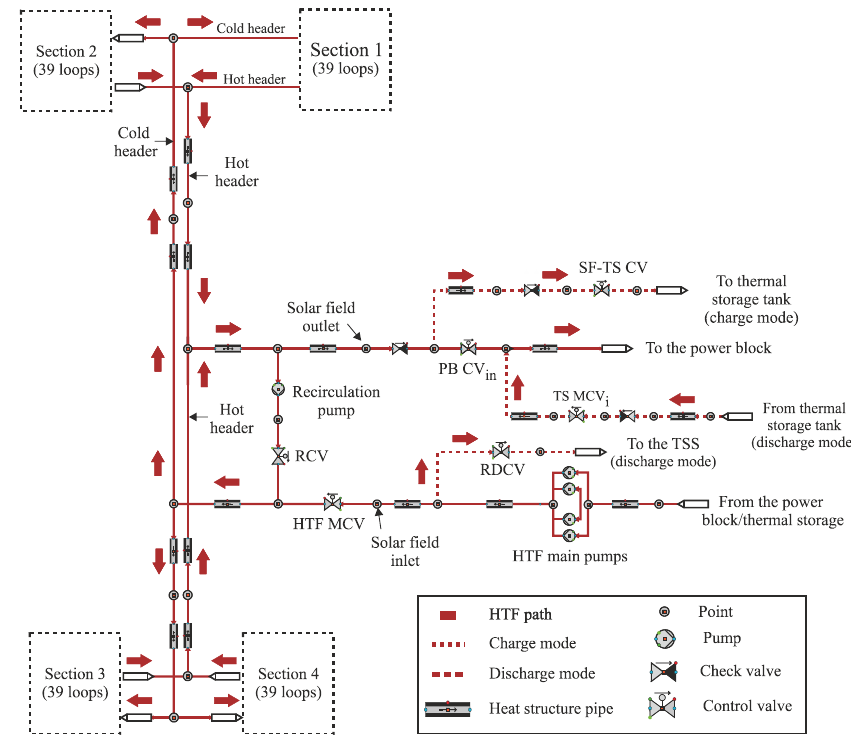
Figure 3. Solar field circuit.